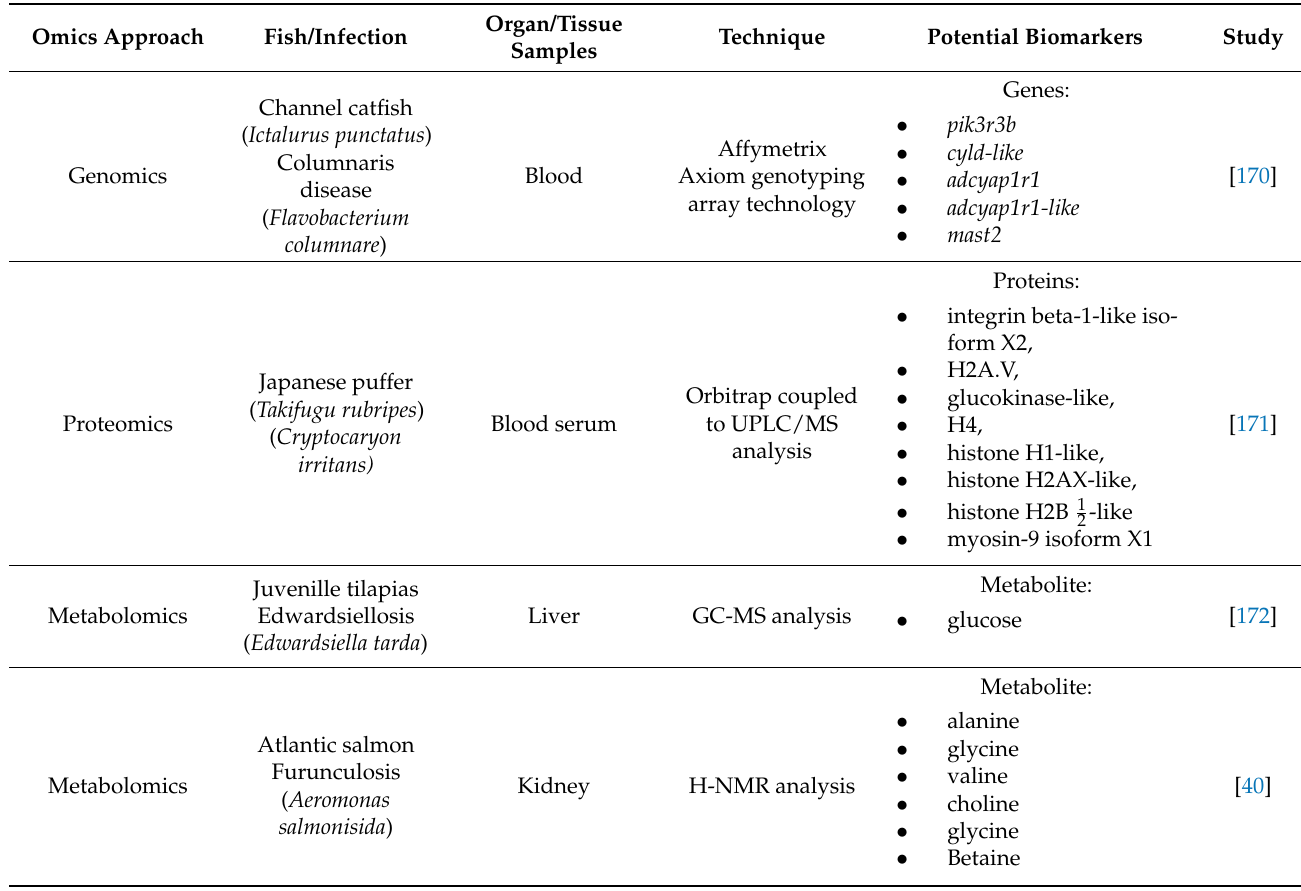
Table 3. Biomarker discovery using omics